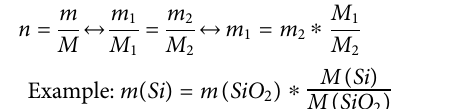
For paleoenvironmental interpretation, single element distributions and ratios are commonly used (e.g., Rothwell and Croudace, 2015; Longman et al., 2019).